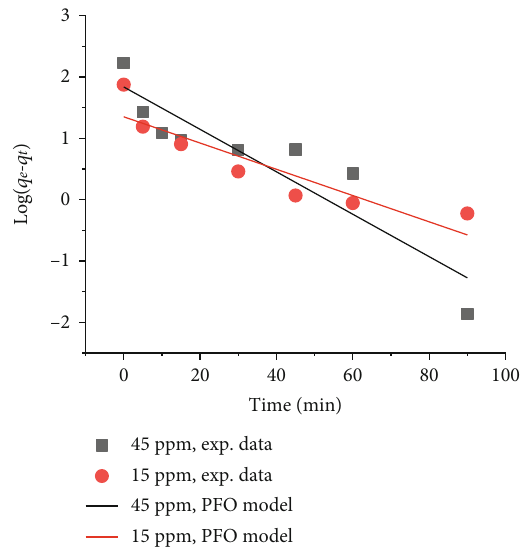
Figure 5: PFO kinetic plot for the adsorption of CV onto PACK. Conditions: C = 15 , 45ppm; adsorbatevolume = 500 mL ; 0 temperature = 25 ° C ; adsorbent = 0 : 04g ; agitation = 150rpm ; time = 90 min .